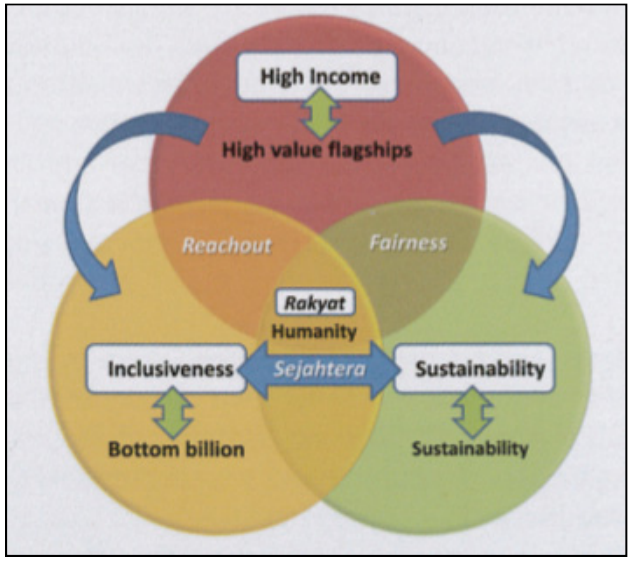
Figure 1. APEX Agenda in the National Context. Source: ([29], p. xi).